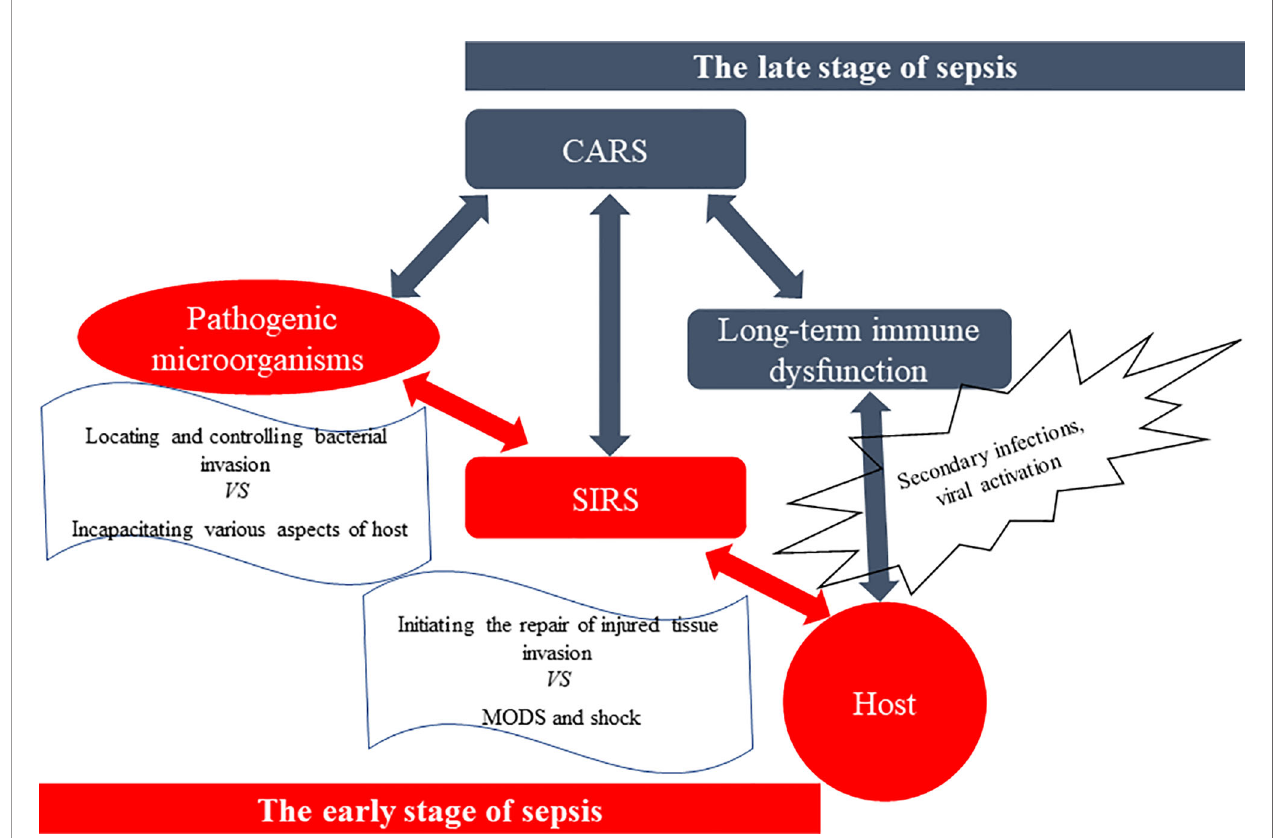
FIGURE 2 | The antagonism between the host and pathogenic microorganisms. The spread of pathogens, especially Gram-negative bacteria, and their products [such as lipopolysaccharide (LPS), etc.] causes systemic in fl ammatory response syndrome (SIRS), which leads to multiple organ dysfunction syndromes (MODS) and shock, and even death. However, surviving patients suffer from a stage of compensatory anti-in fl ammatory response syndrome (CARS), especially immunosuppression, and experience a long-term immune dysfunction called immuno-paralysis. And they are more susceptible to secondary infections, increased viral activation, and reduced 5-year survival rate, compared to those who do not have